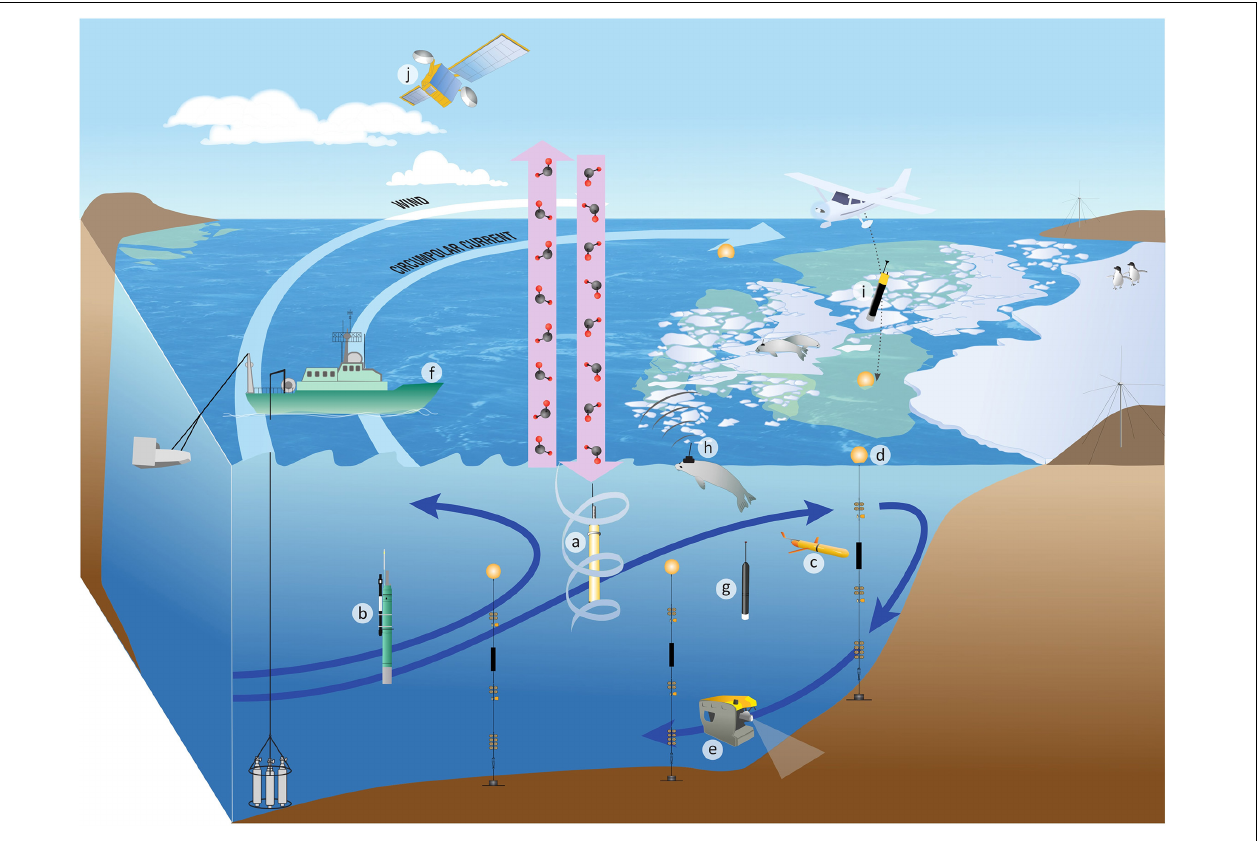
FIGURE 9 | Components of an optimal observing system to constrain and quantify biogeochemical cycling processes in the Southern Ocean. New methodologies such as biogeochemical sensors deployed on SOCCOM (a) and SOCLIM (b) floats, gliders (c) , and moorings (d) , and sampling from ROVs (e) must be integrated with traditional ship- (f) and station-based approaches. Ice-capable bio-Argo floats (g) and biogeochemical sensors deployed on marine mammals (h) are needed to extend the observational range in time and space. Airborne deployment of ALAMO floats (i) could increase spatial coverage substantially. All of these in situ approaches should be combined with existing and improved satellite-based measurements (j) of sea surface height, sea ice, sea surface temperature, and ocean color to develop an integrated biogeochemical observing system for the Southern Ocean. Modified from Meredith et al.